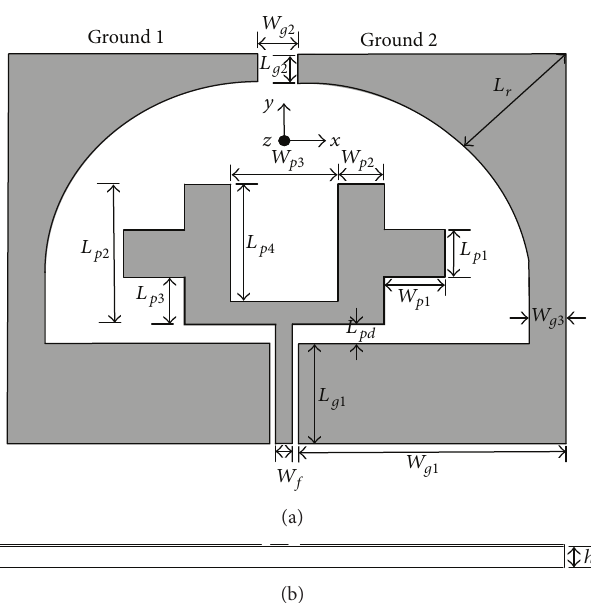
Figure 1: Schematic configuration of the proposed CPW-fed two- sided T strip wideband microstrip antenna.